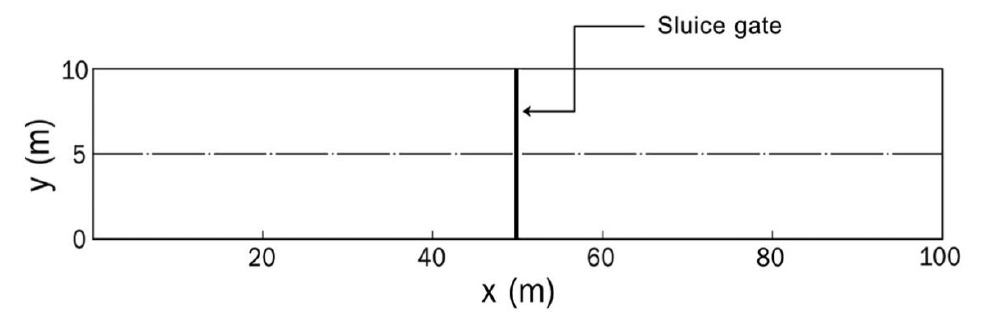
Table 1. Initial conditions of the four numerical tests [33].